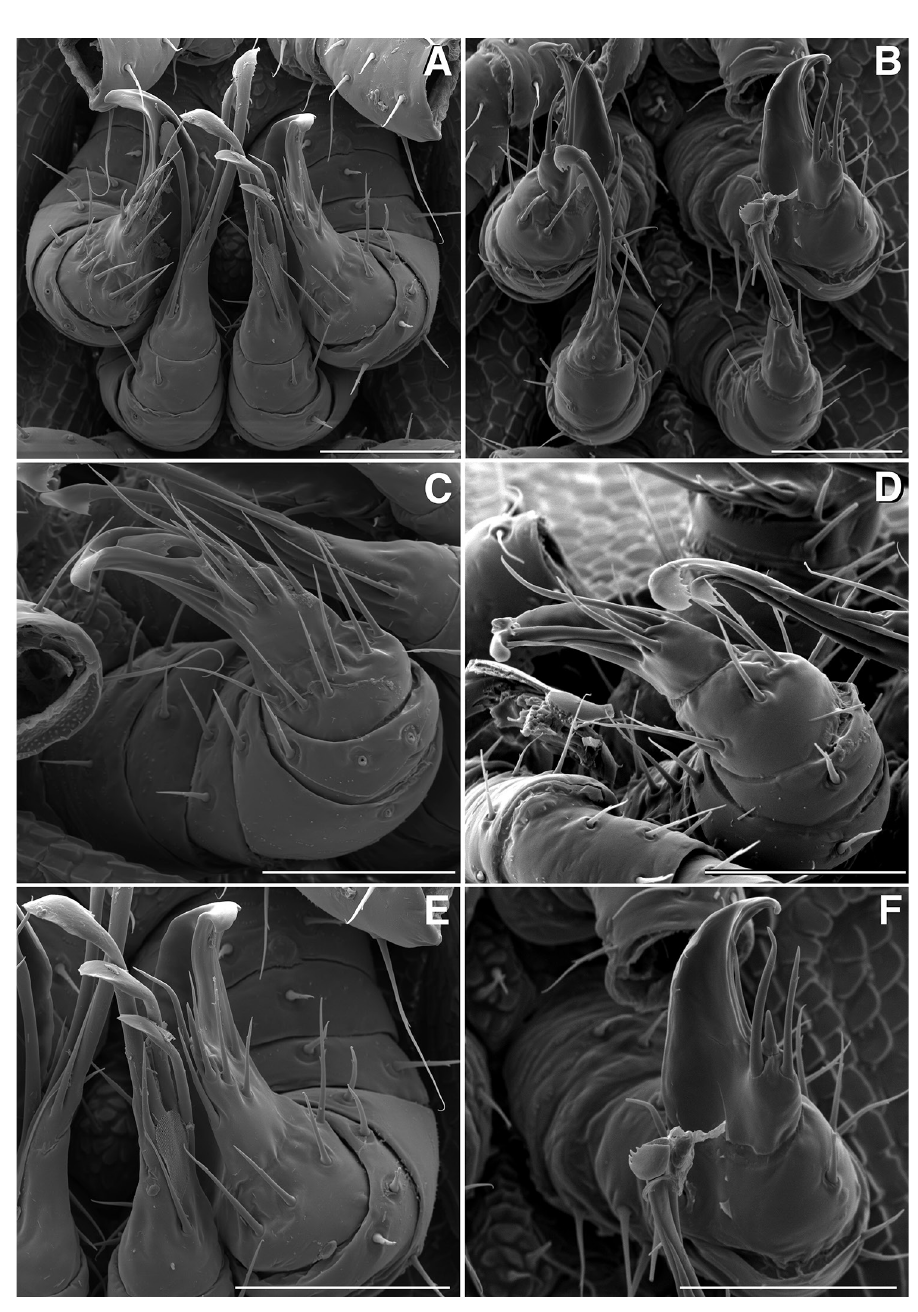
Figure 9. A Ventral view of gonopods of I. tobini sp. n. (scale bar 50 µm) B the same of I. plenipes (scale bar 50 µm) C Lateral (right) view of right anterior gonopod (leg-pair 9) of I. tobini sp. n. (scale bar 50 µm) D the same of I. plenipes (scale bar 50 µm) C Ventral view of gonopods of I. tobini sp. n. (centered on right anterior gonopod) (scale bar 50 µm) D the same of I. plenipes (scale bar 50 µm). (Catalog #s: I. tobini sp. n. MPE00735, I. plenipes